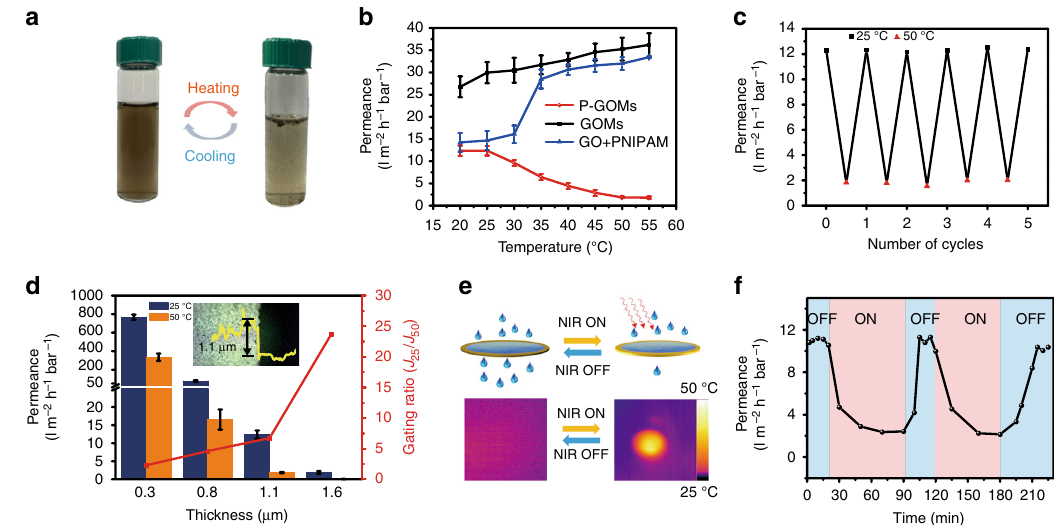
Fig. 3 Thermal- and photo-gating performances of P-GOMs. a P-GO sheets re-dispersed and aggregated upon cooling and heating of the aqueous dispersion between 25 °C and 50 °C, indicating the temperature-responsive property of P-GO. b Temperature-dependent water permeance curves of GOMs, P-GOMs and physically blending PNIPAM/GO membranes, P-GOMs show the unique negative temperature-responsive coef fi cient, which is opposite to the positive coef fi cient of GOMs and GO/PNIPAM blending membrane. Error bars, s.d. ( n = 3). c Reverse stability test of the temperature- responsive water gating property of P-GOMs. d Thickness-dependent water permeance and gating ratio of P-GOMs, 1.1 μ m thickness is adopted after balancing the water permeance and high gating ratio. Error bars, s.d. ( n = 3). e Schematic showing the water permeance of P-GOMs decreased after irradiation of near-infrared (NIR). The bottom pictures are thermographic images of P-GOMs before and after irradiation of NIR. f The water permeance of P-GOMs decreases when switching on NIR light and returns to initial values when the NIR light is